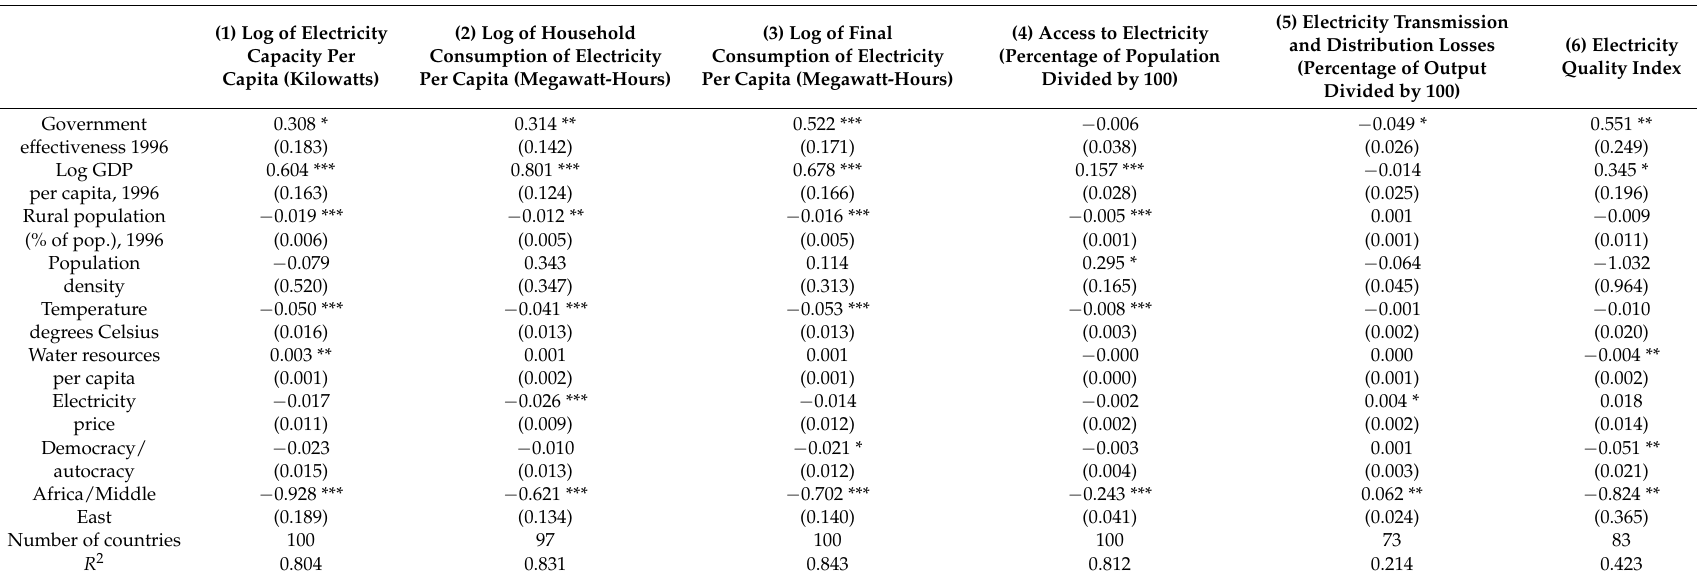
Table 3. Results, lagged government effectiveness and electricity use,